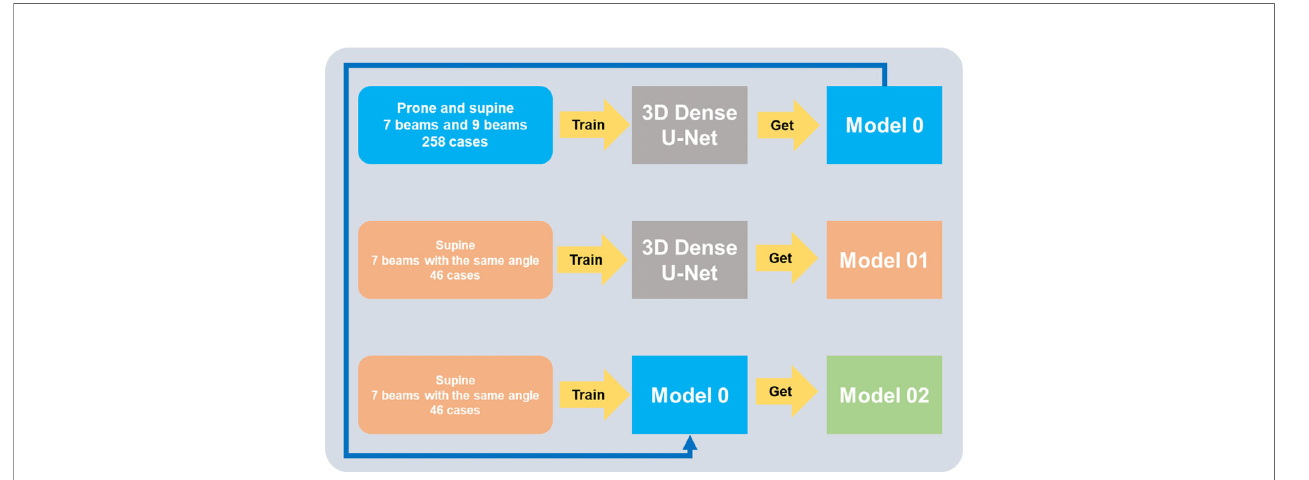
FIGURE 3 | Experiments to prove a full-database pre-trained strategy.